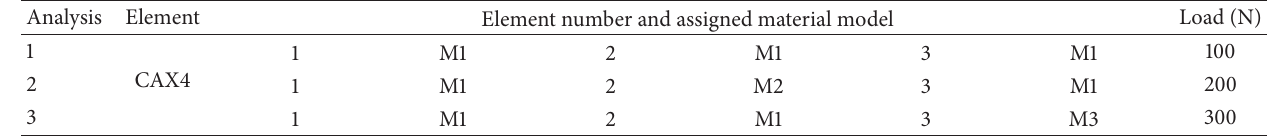
Table 6: The combination of different materials for element.